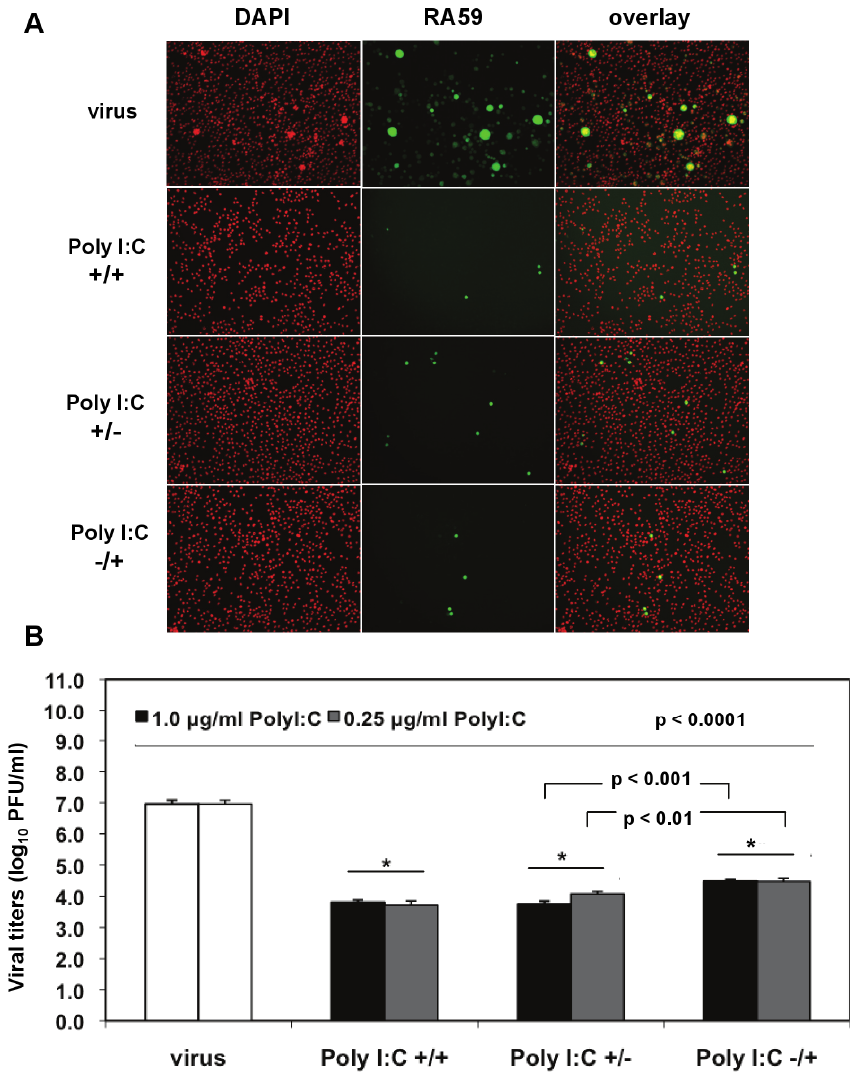
Figure 4. Prestimulation with poly I:C before virus adsorption is sufficient to trigger a profound antiviral effect in MHV-infected macrophages. ( A ) J774A.1 macrophages were prestimulated with poly I:C for 6 h and coactivated during RA59-GFP (1 MOI) infection for 18 h postadsorption at concentrations of 0.25 and 1.0 μ g/mL of the TLR3 ligand. Cells were treated as follows: (1) poly I:C prestimulated only (poly I:C +/ − ); (2) poly I:C coactivated only after virus adsorption (poly I:C − /+); and (3) poly I:C-treated before and after virus adsorption (poly I:C +/+). Unstimulated but infected macrophages served as a negative control for poly I:C antiviral effect. RA59-GFP infection was visualized at the original magnification x100. The data shown are representative images of two independent wells for cells treated with 0.25 μ g/mL poly I:C. Original magnification x100. ( B ) RA59-GFP titers were assessed in cell-free supernatants from ( A ) using a plaque assay on L2 fibroblasts. Error bars represent the standard error of the mean of two replicates (* p value relative to virus alone; other p values relative to Poly I:C-pre-stimulated cells only, Student’s t